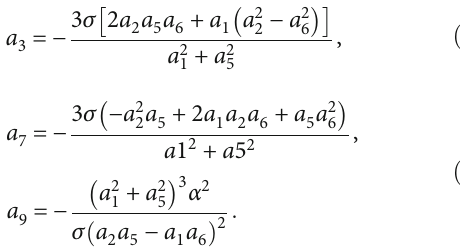
= 1 , k = 2 , k = 2 , 1 2 3